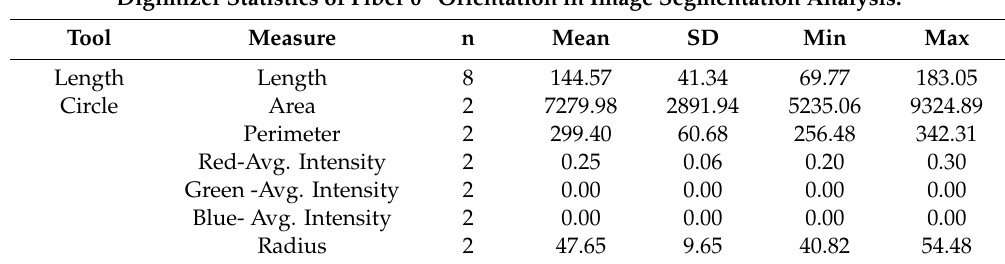
Table 7. Digimizer statistics of fiber 0 ◦ and 45 ◦ orientations in image segmentation